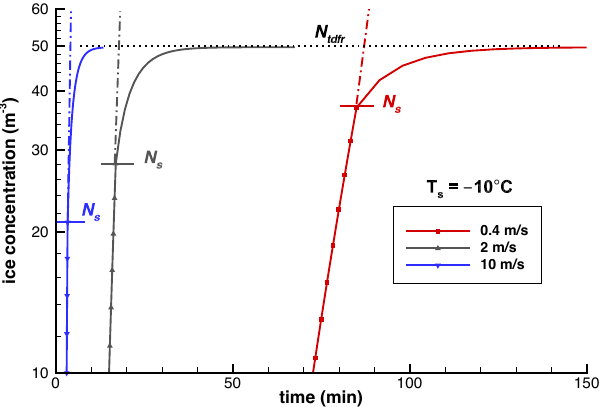
Figure 1. Time evolution of ice particle concentration in a parcel of air undergoing lifting at three different updraft velocities. Cloud base is at 700mb and +2 ◦ C. Lifting stops at − 10 ◦ C and the parcel remains at that level. The TDFR model is initialized with an INP concentration given by Eq. (3). The horizontal line segments at N s indicate the ice concentrations when the lifting stops. Note that the greater the updraft velocity is, the lower the value of N s is. N tdfr is the asymptotical value of ice concentration while the parcel is at − 10 ◦ C.